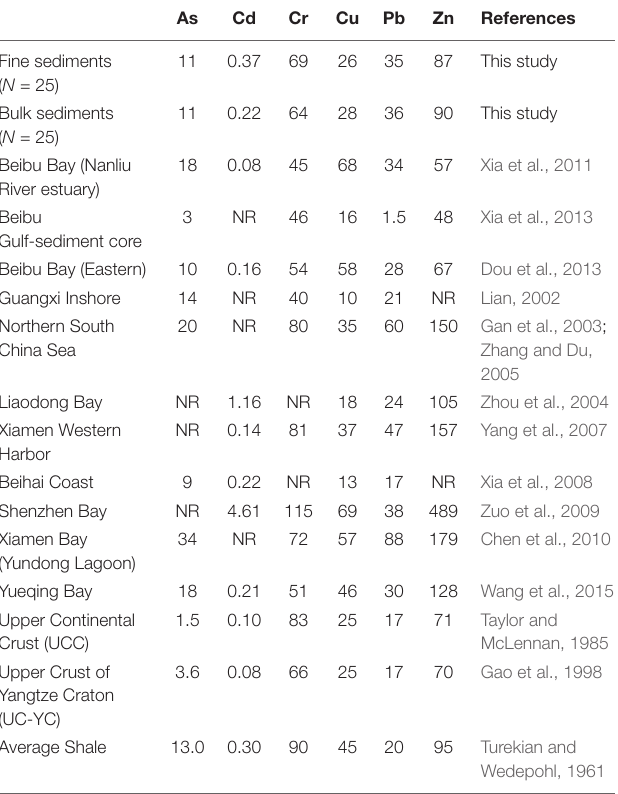
TABLE 4 | Mean concentrations (ppm) of total trace metals in coastal surface sediments in the Gulf of Tonkin compared with the reported values of trace metals from other areas of the Gulf and China. Also shown are the values of trace metals from some reference materials.